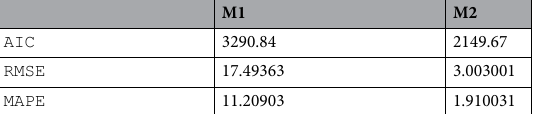
Table 2. Comparison of the two different ARIMA models for living donors: Model 1 with seasonality (ARIMA(6,1,0)(2,1,0)) with drift) and Model 2 with seasonally adjusted data constructed by removing the seasonal component (ARIMA(0,1,5) with drift).